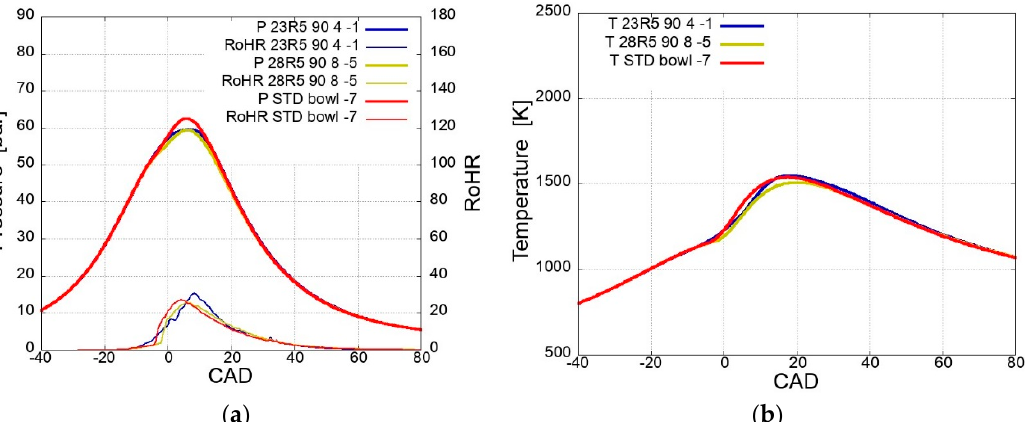
Figure 12. In-cylinder pressure and rate of heat release ( a ) and temperature ( b ) at PL (BMEP = 4 bar, 3000 rpm) .